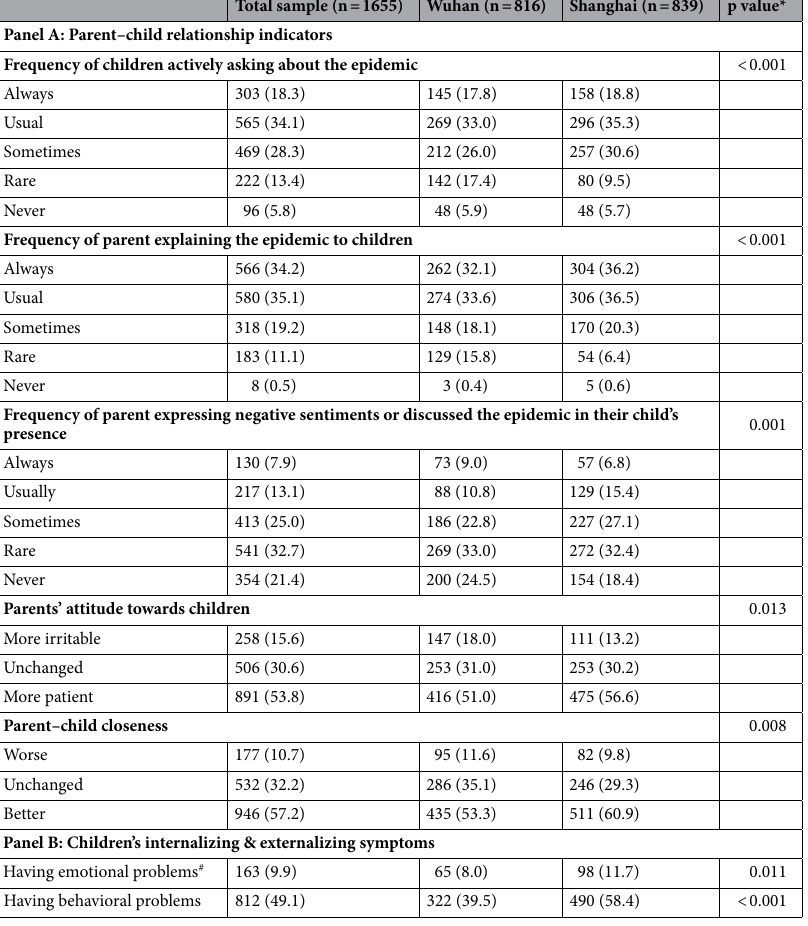
Table 2. Parent–child relationship, and children’s internalizing and externalizing symptoms during the COVID-19 epidemic in Wuhan and Shanghai, n (%). *p value are from Chi square or fisher’s exact tests (when applicable). # One’s SDQ-Emotional Symptoms Score > 4 for parent version or > 6 for child version was considered to have substantial risk of clinically significant emotional problems (in short, having emotional